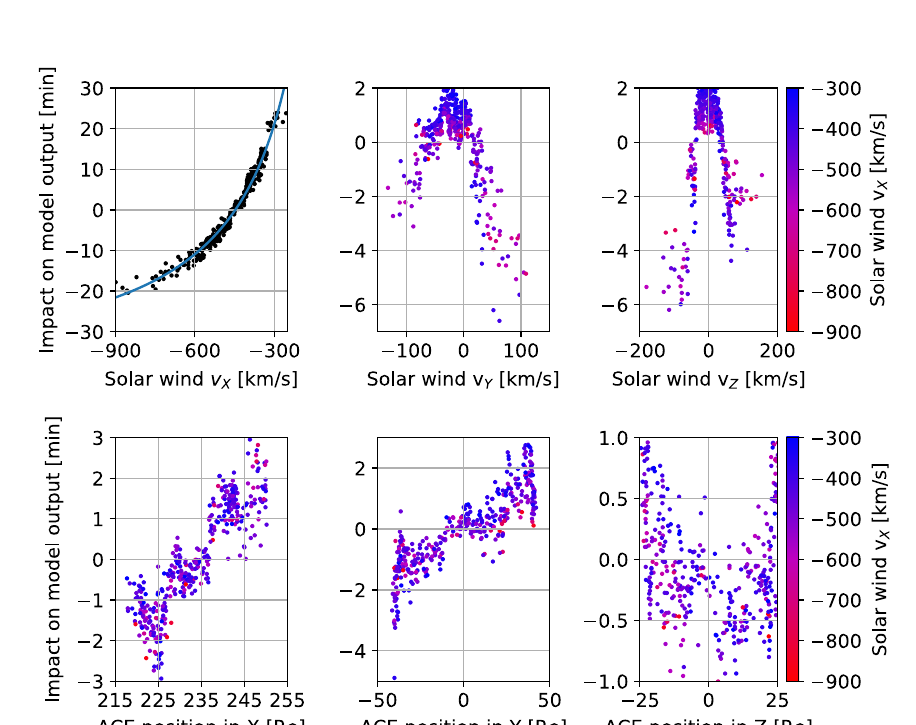
Fig. 10. Shapley values for all six ML features, (a) solar wind speed in X -direction, (b) solar wind speed Y -direction, (c) solar wind speed Z - direction, (d) ACE position in X -direction, (e) ACE position in Y -direction, (f) ACE position in Z -direction, color-coded is the solar wind speed in X